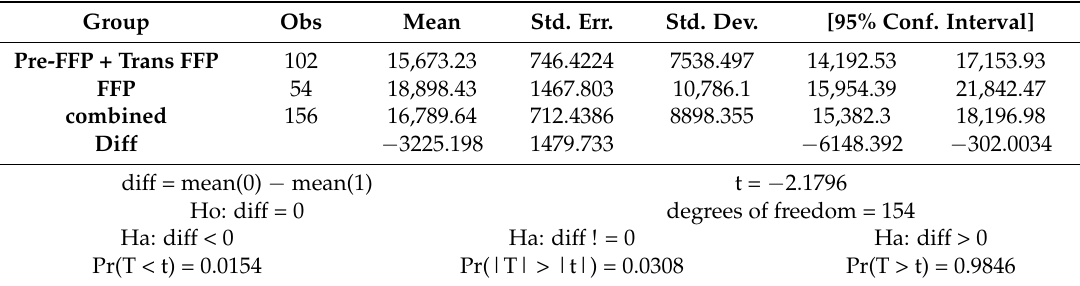
Table 3. Two-sample t-test with equal variances (Financial Fair Play (FFP)).